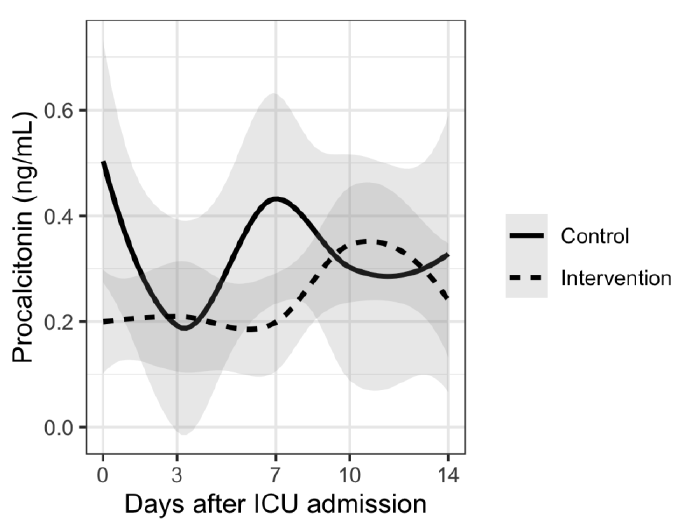
Figure 2 . Mean procalcitonin levels and trends during 14 days from ICU admission.